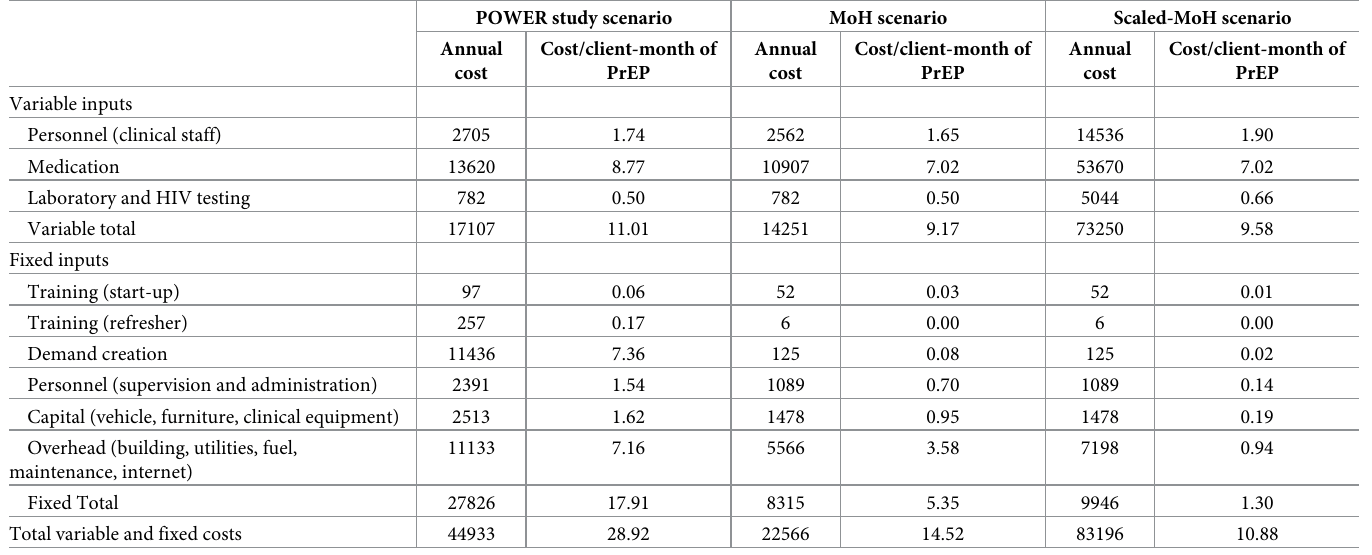
Table 2. Estimated total and average economic costs (2019